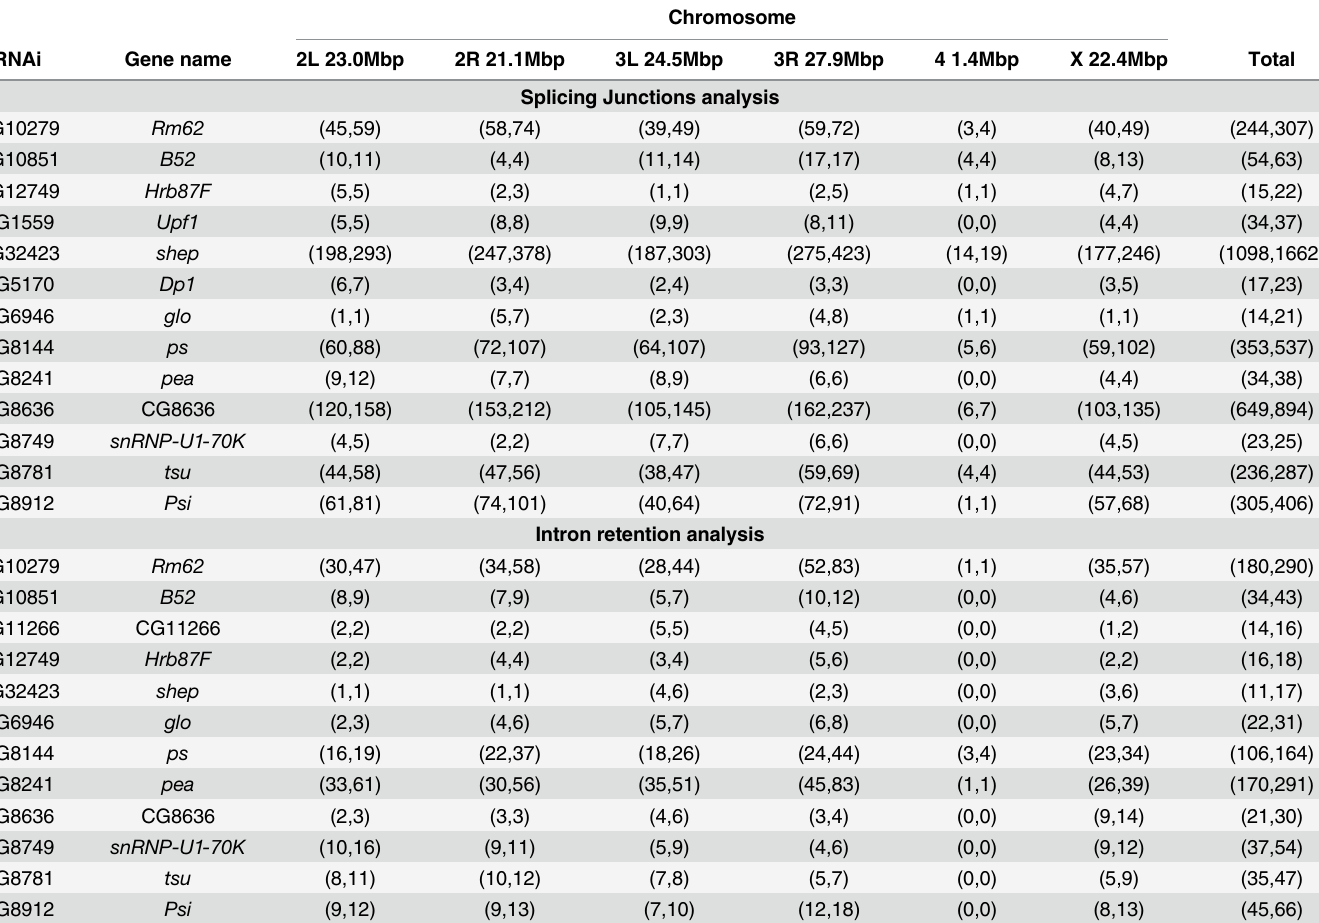
Table 1. Number of significant signals and genes on each